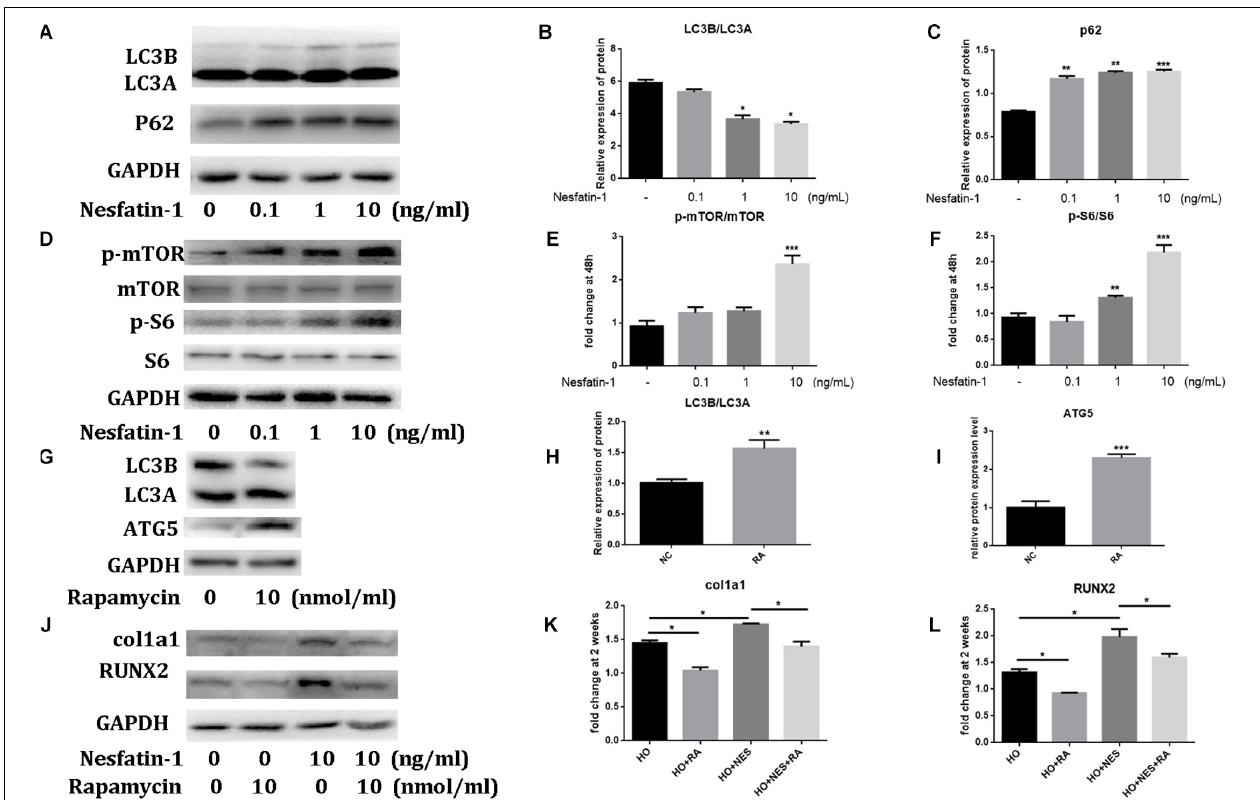
FIGURE 5 | The effect of Nesfatin-1 on osteogenic differentiation and autophagy via the mTOR pathway. (A–C) The TDSCs were treated with different concentrations of Nesfatin-1 for 6 h. The expression levels of LC3A, LC3B, and p62 were evaluated via Western blot. (D–F) The TDSCs were treated with different concentrations of Nesfatin-1 in osteogenic induction medium for 14 days. The expression levels of p-mTOR, mTOR, p-S6, and S6 were evaluated via Western blot. (G–I) Rapamycin (10 nmol/mL) was used to inhibit the activation of the mTOR pathway and activate the autophagy. (J–L) The Nesfatin-1-induced osteogenic response can be inhibited by rapamycin. * p < 0.05, ** p < 0.01, *** p <